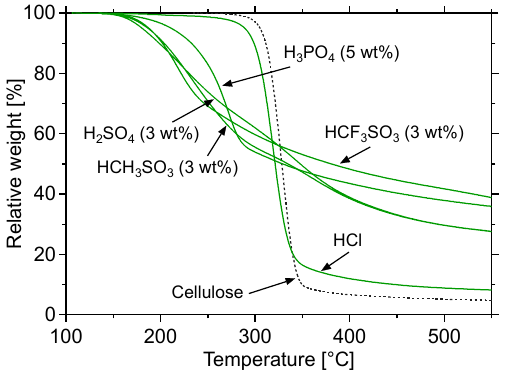
Figure 6. Weight loss curves of cellulose and cellulose impregnated with inorganic or organic acids; TGA under flowing nitrogen with 5 °C/min heating rate.